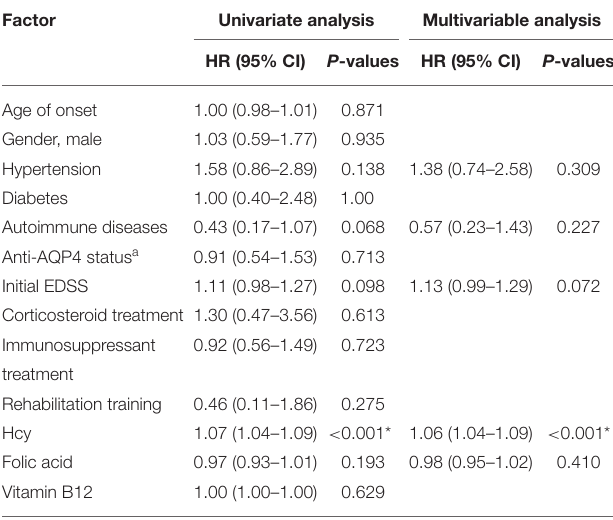
TABLE 3 | Predictors of relapse in NMOSD patients by univariate and multivariable Cox proportional hazards models. Factor Univariate analysis